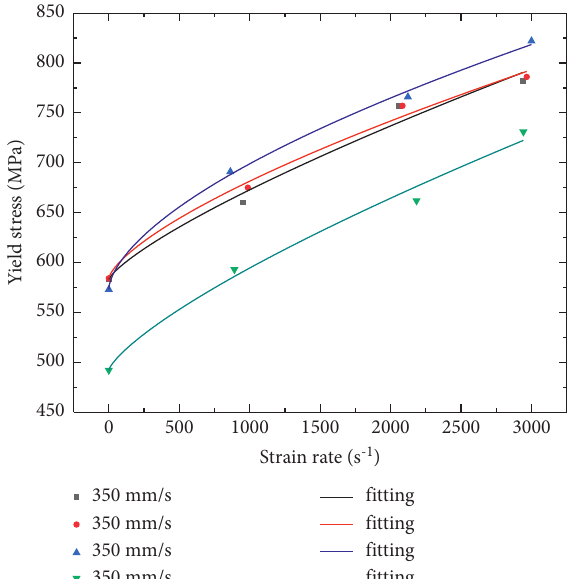
Figure 13: The modified fitting curve of parameter C